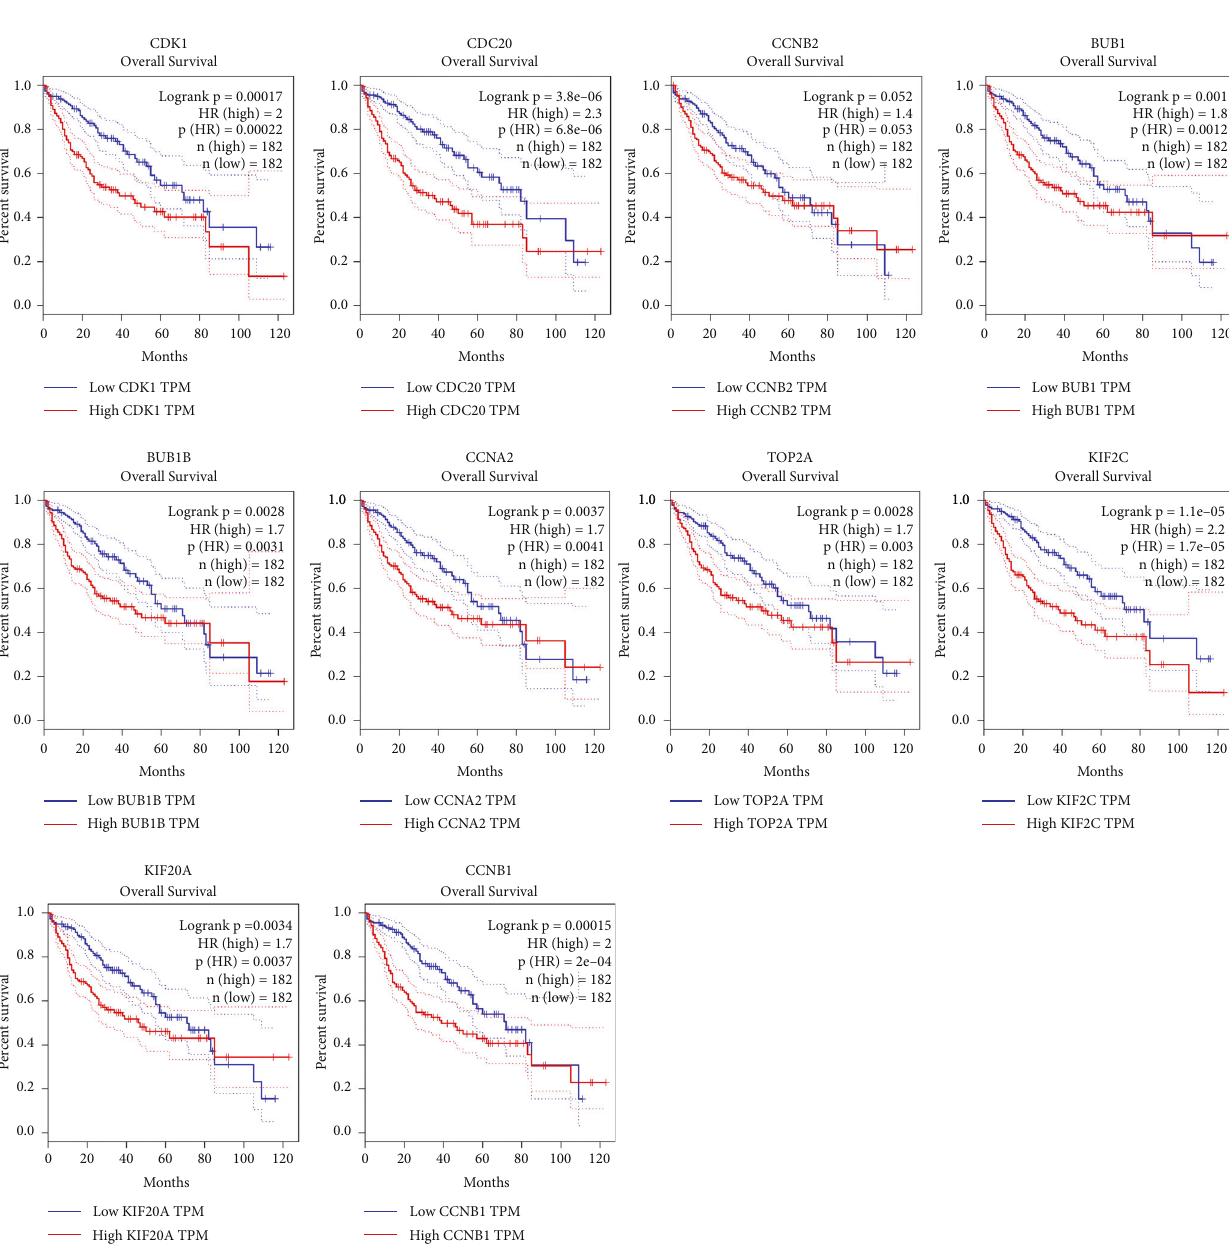
under biological process, the DEGs were mainly classi fi ed into “ tubulin binding, ” “ motor activity, ” “ microtubule motor activity, ” “ microtubule binding, ” andsoon(Figure3(a));incel- lular component, DEGs were mainly classi fi ed into “ spindle mid- zone, ” “ spindle microtubule, ” “ spindle, ” and “ mitotic spindle ” (Figure 3(b)); in molecular function, DEGs were mainly classi fi ed into “ spindle, ”“ chromosome,centromericregion, ” and “ chromo- somal region ” (Figure 3(c)). In KEGG enrichment analysis, DEGs were mainly classi fi ed into “ progesterone-mediated oocyte matu- ration, ” “ p53 signaling pathway, ” “ oocyte meiosis, ” “ cellular senescence, ” “ cell cycle, ” and “ bladder cancer ” (Figure 3(d)).